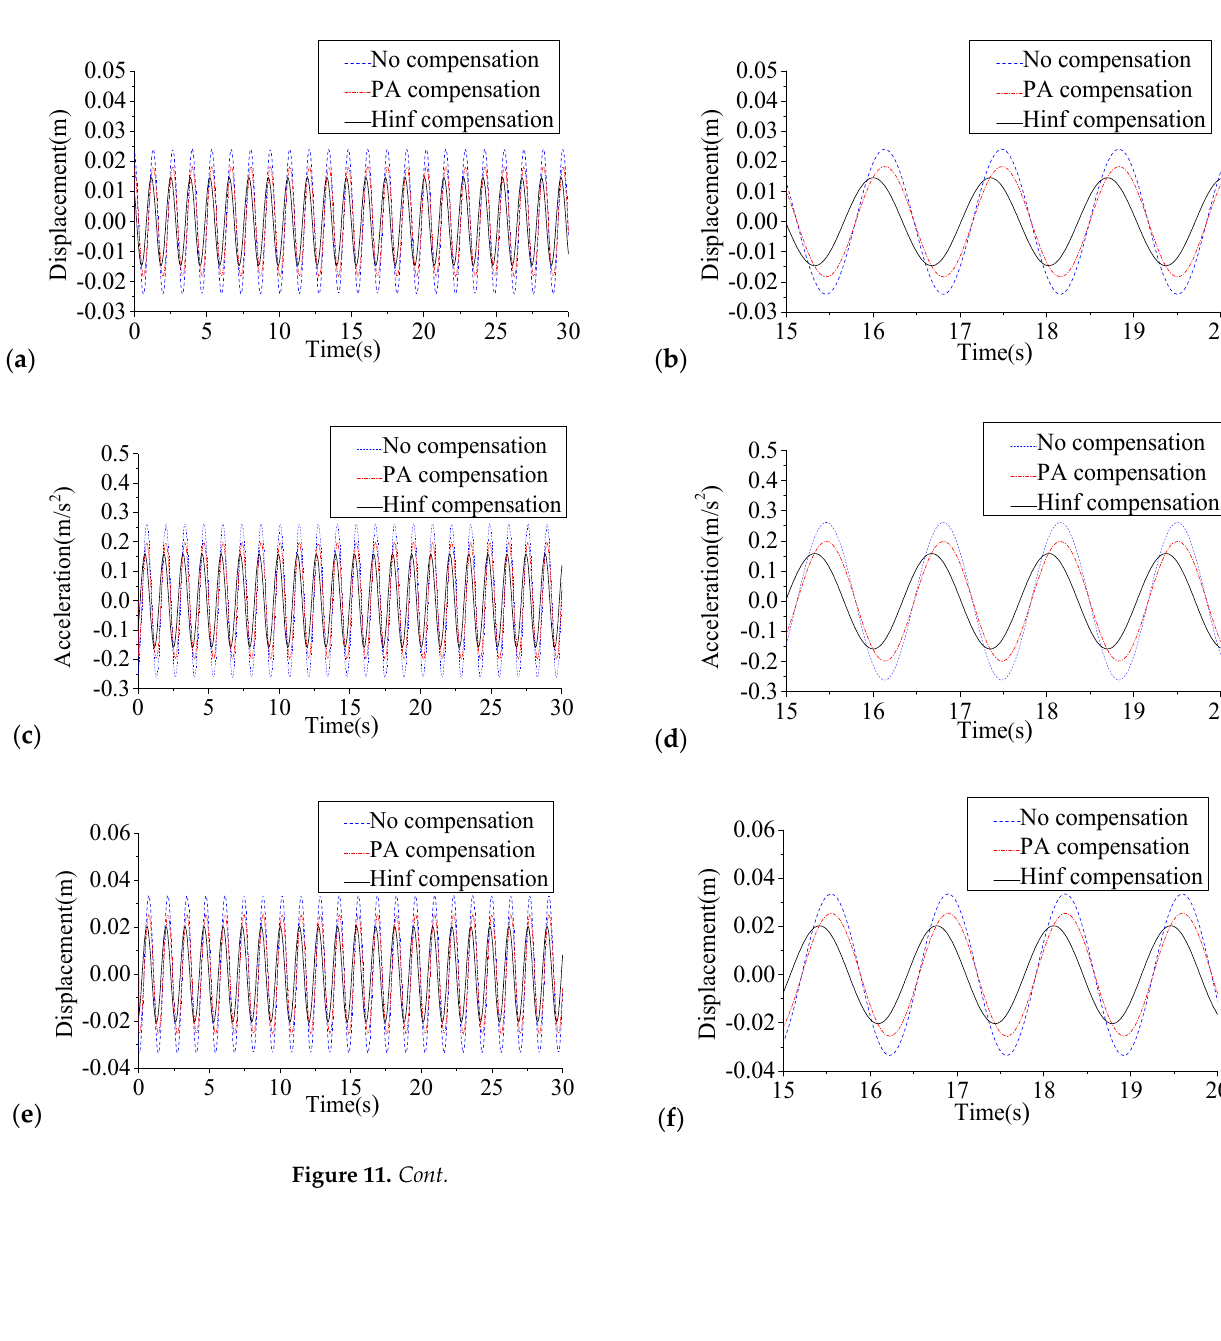
Table 4. The control effects under the measured results (mean square values).